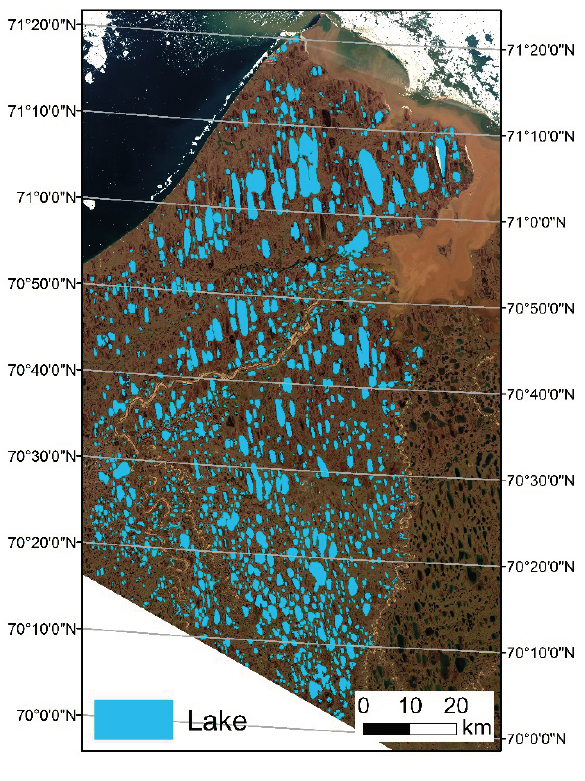
Figure 8. Barrow study area with lakes divided into 8 bins of 10-min latitudinal intervals on top of a Landsat 8 image.